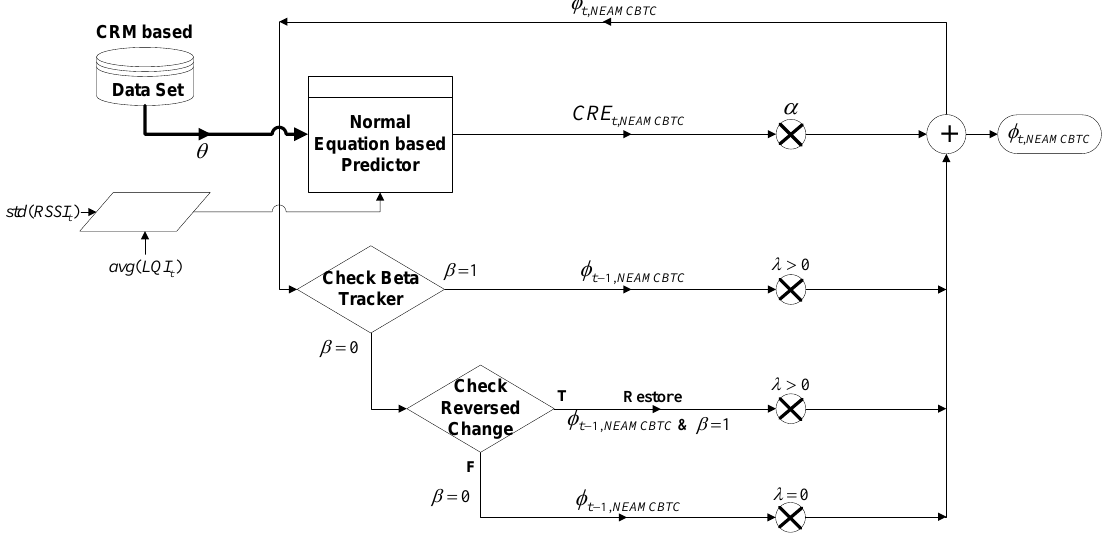
Figure 5. Data flow diagram of NEAMCBTC